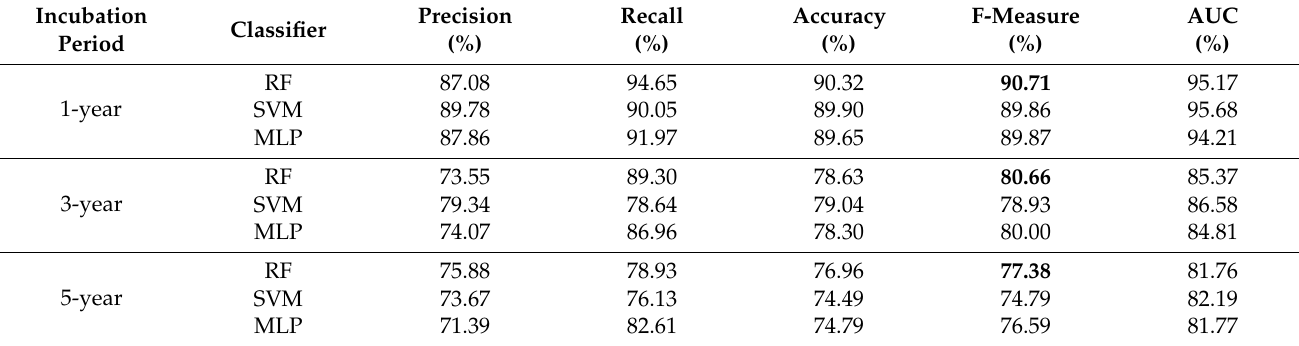
Table 5. Performance with application of the machine learning algorithms to each incubation period model. Incubation